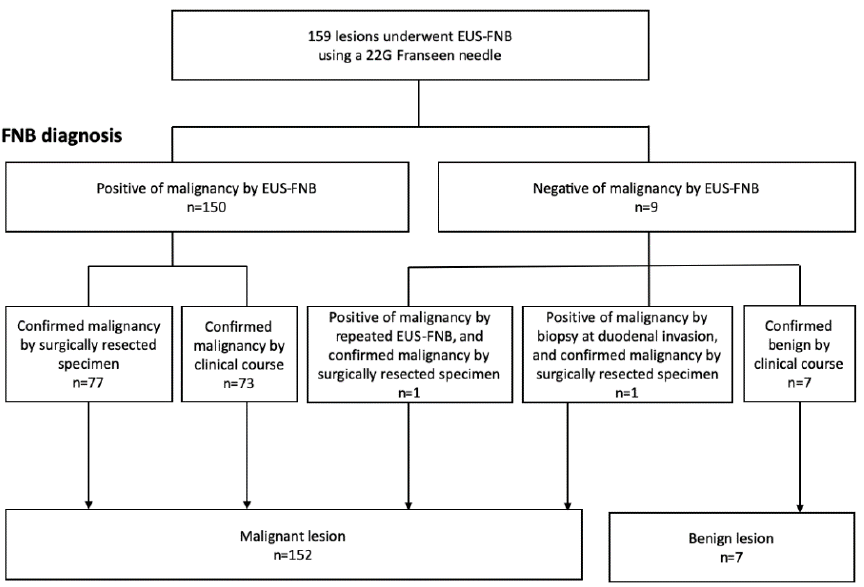
Figure 1. Flowchart of diagnosis via endoscopic ultrasound-guided fine-needle biopsy (EUS-FNB). ERCP, endoscopic retrograde cholangiopancreatography.